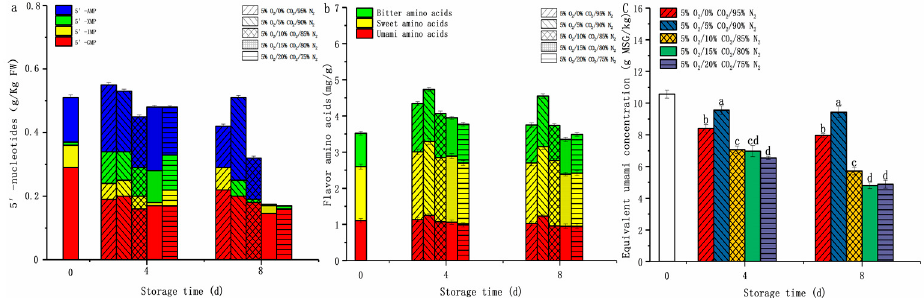
Figure 6. Effect of CO 2 concentration (%) with 5% O 2 on 5 ′ -nucleotides ( a ), flavor amino acids ( b ), and equivalent umami concentration ( c ) of fresh-cut Dictyophora rubrovolvata . Differences at p < 0.05 are indicated by different letters and data are expressed as the mean ± SD.